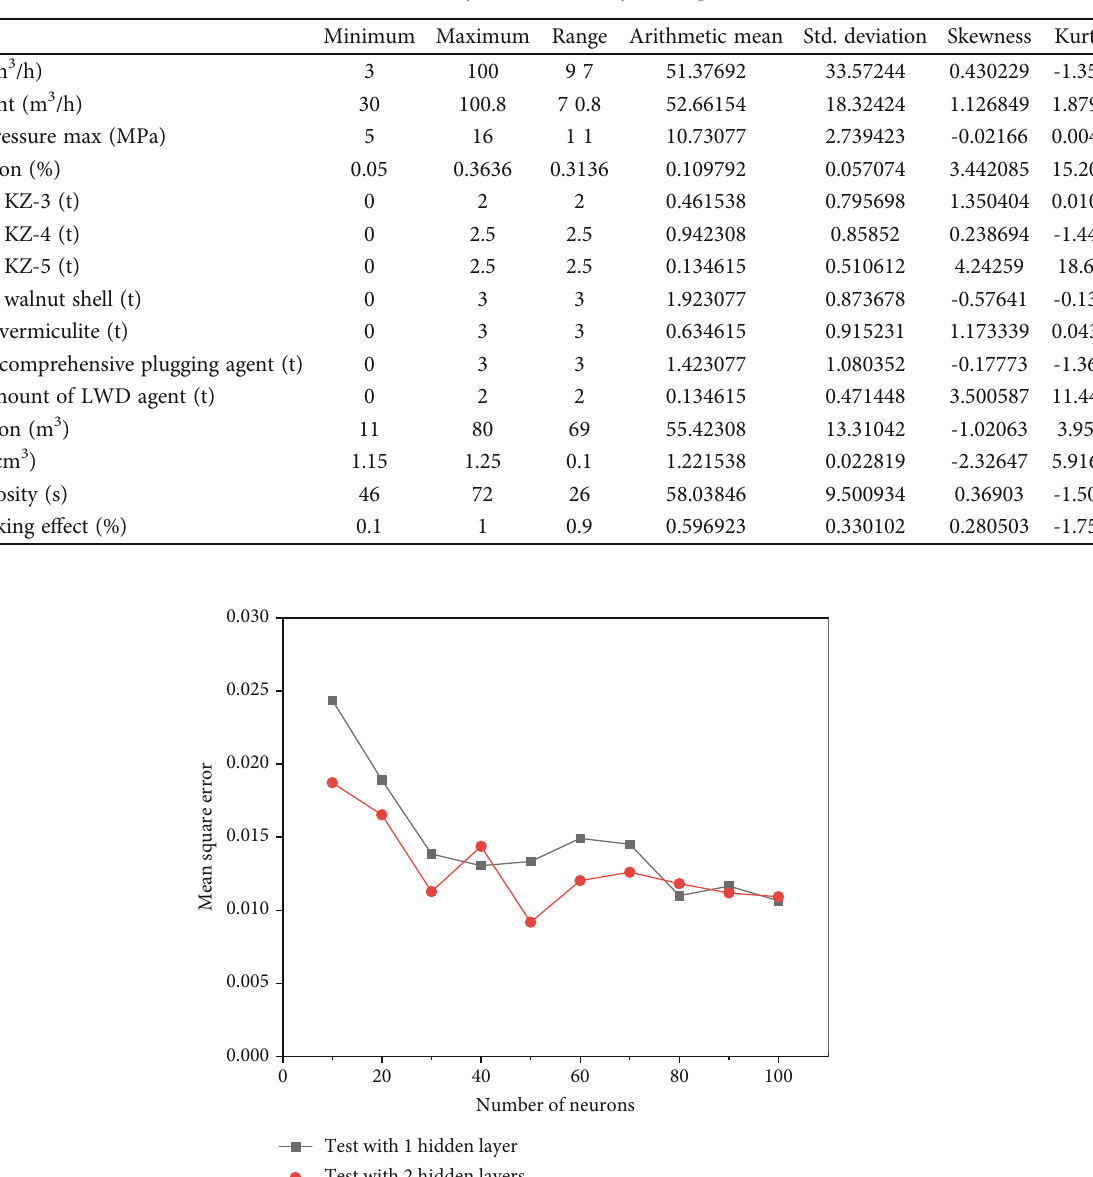
Table 2: Statistical analysis and summary of sample data.